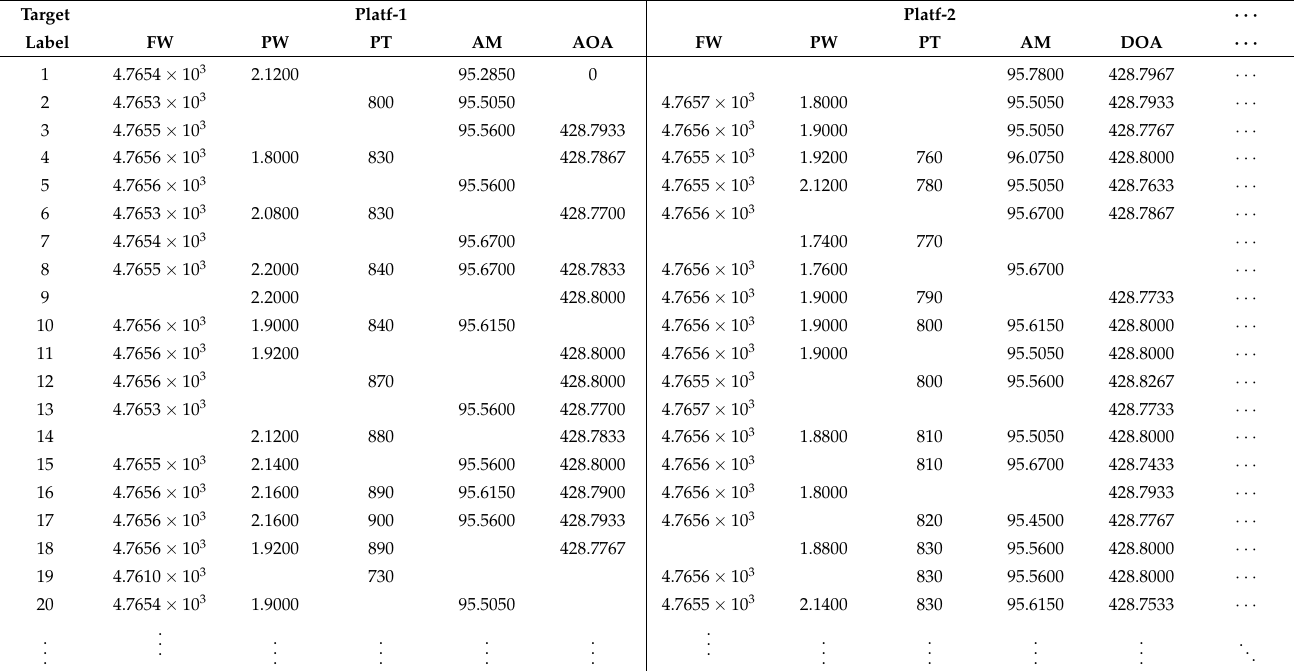
Table 8. Recorded real data D with missing annotations.